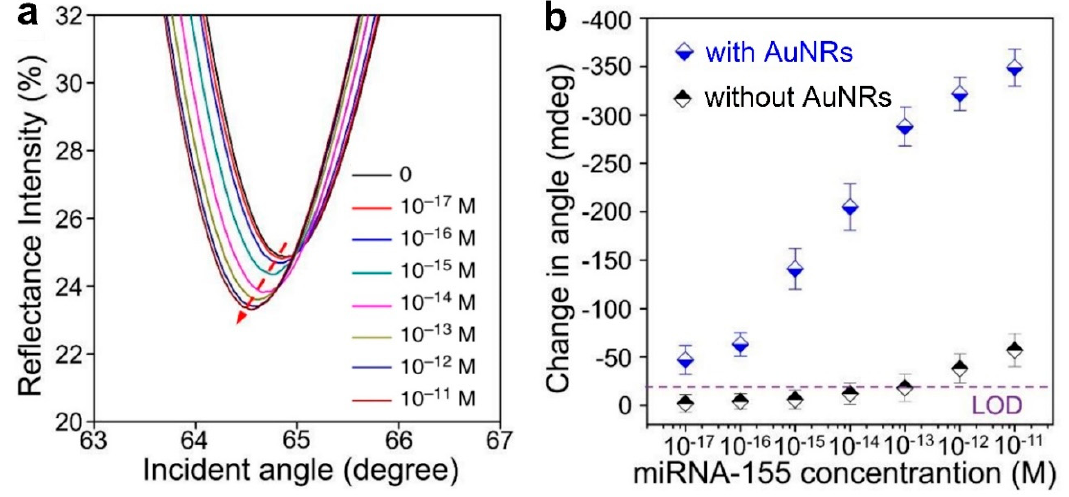
Figure 9. ( a ) Surface plasmon resonance (SPR) spectra with miR-155 concentrations ranging from 10 − 17 to 10 − 11 M obtained using gold nanorod (Au NR) amplification. The arrow denotes the shift in the SPR angle. ( b ) Relationship between the SPR angle and miR-155 concentration using DNA probes with and without Au NRs. ( a , b ) Adapted under the terms of the Creative Commons Attribution 4.0 International License (https://creativecommons.org/licenses/by/4.0/) [63]. Copyright 2019, The Authors. Published by Nature Communications.